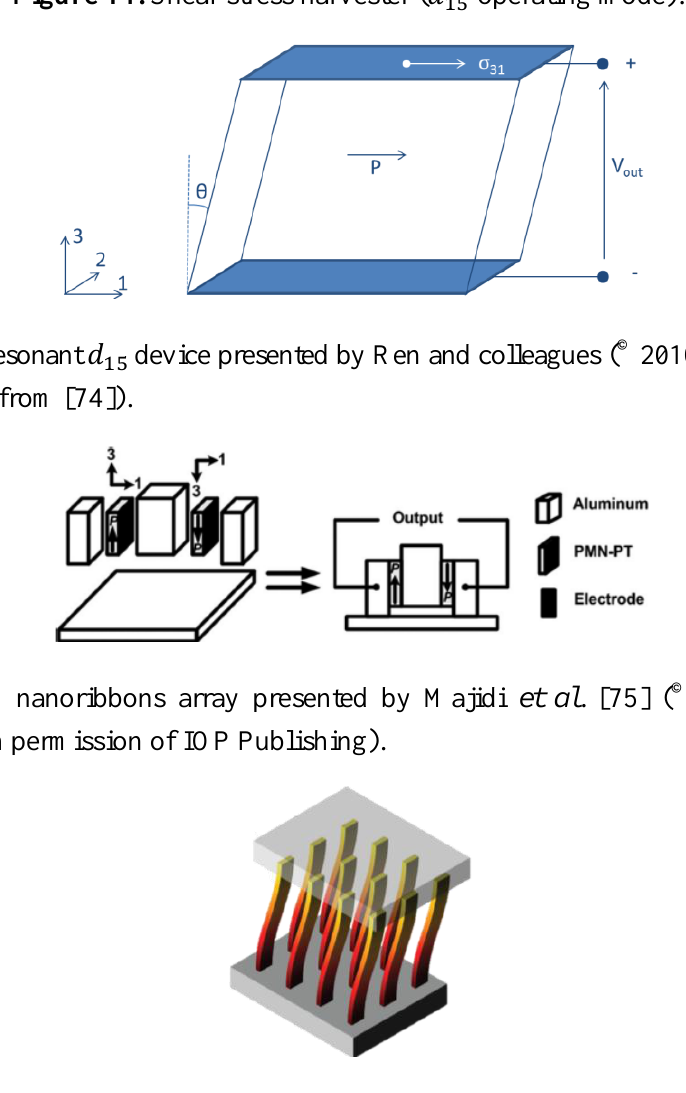
Figure 14. Shear stress harvester ( operating mode).